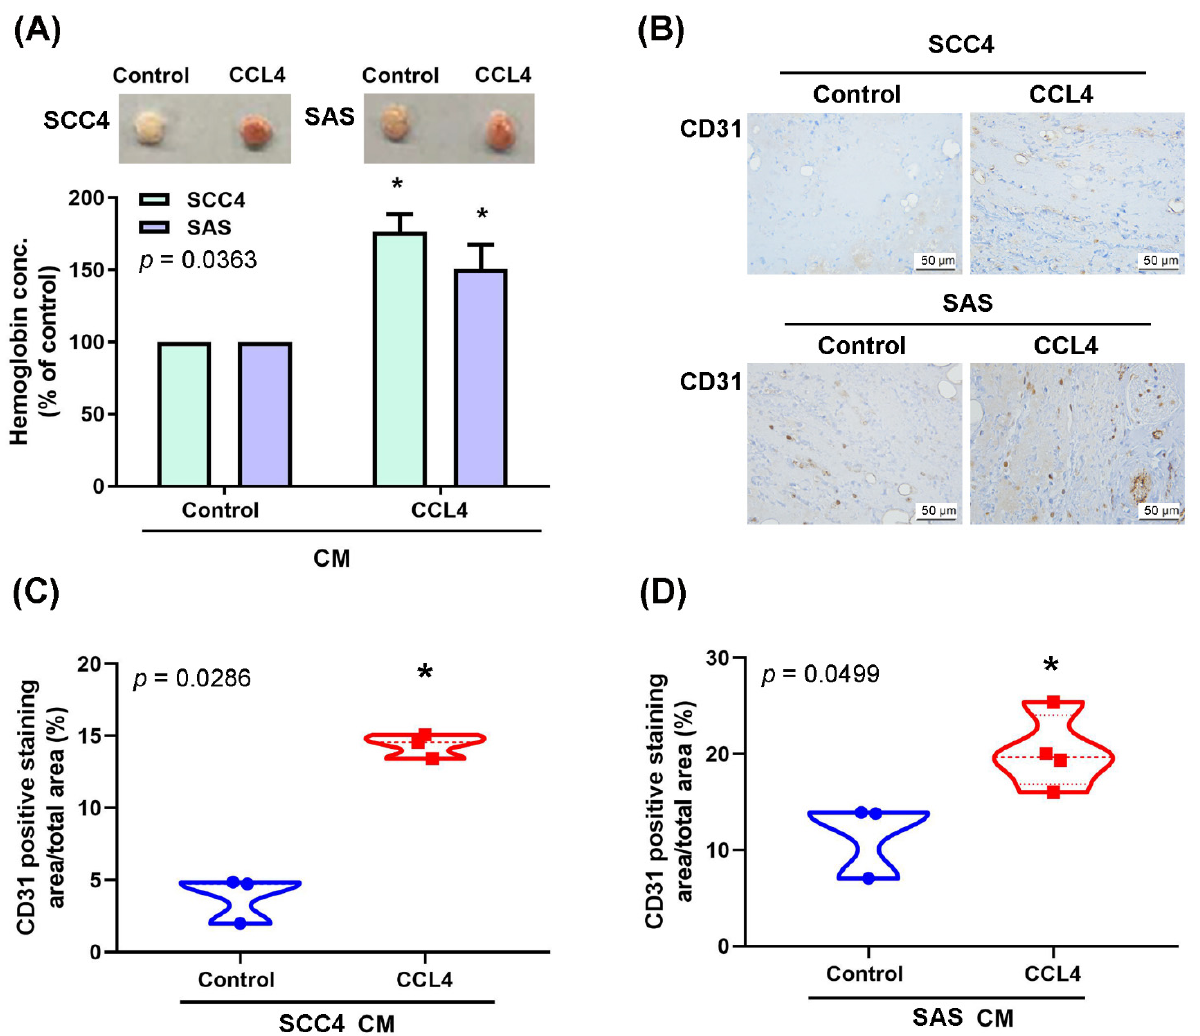
Figure 3. CCL4 promotes OSCC angiogenesis in vivo. Mice were injected subcutaneously with Matrigel containing 0.2 mL CM from OSCC cells (treated with or without CCL4). On Day 14, Matrigel plugs were excised, photographed, quantified for hemoglobin content ( A ), then stained with CD31 ( B – D ). * p < 0.05 compared with controls.